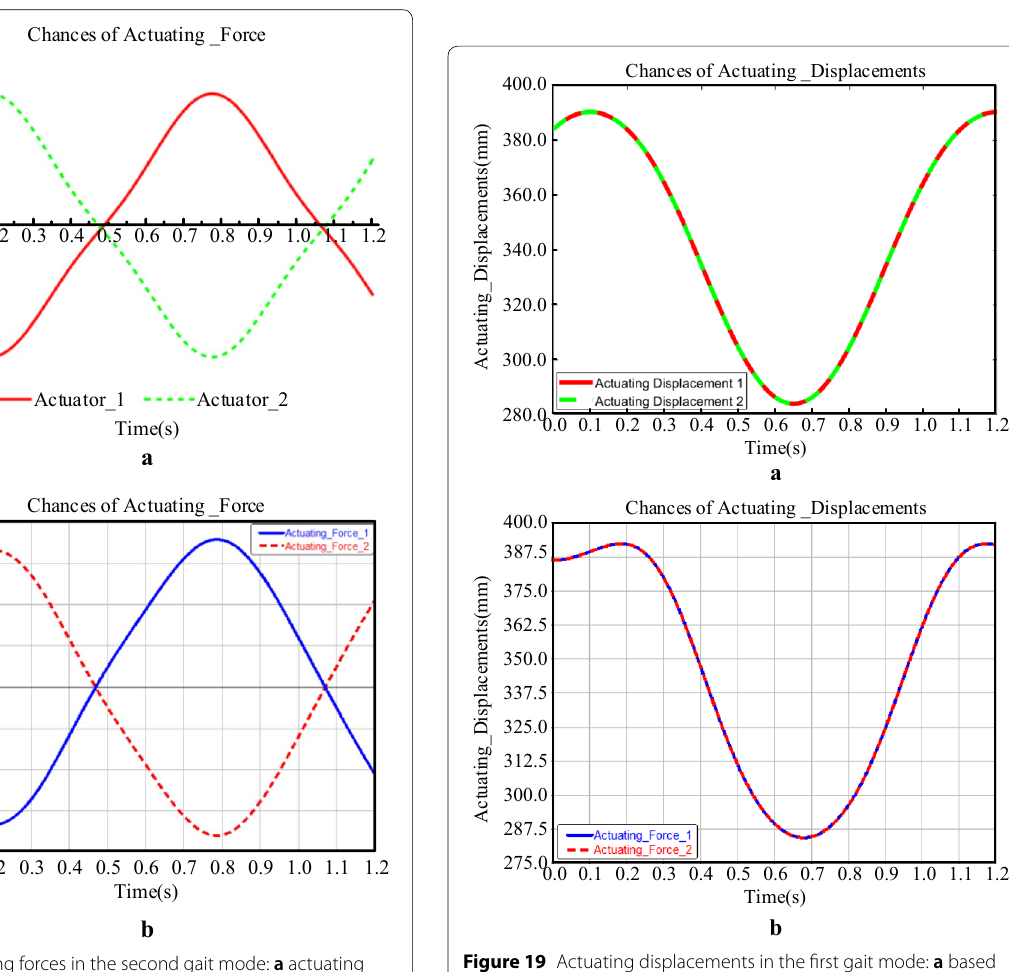
Figure 18 Actuating forces in the second gait mode: a actuating forces by Mathematica; b actuating forces by Adams